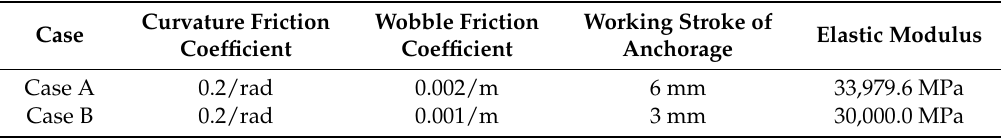
Table 1. Analysis cases for the verification example.